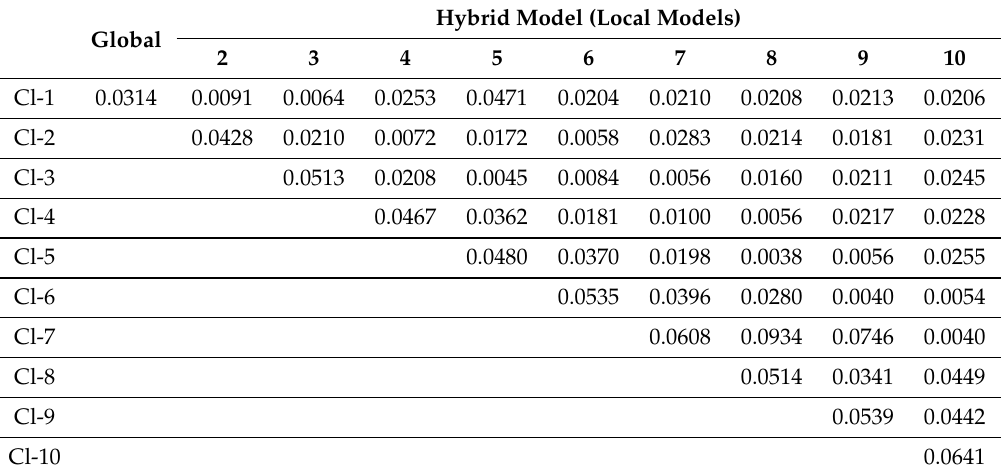
Table 3. MAE for second-degree polynomial regression